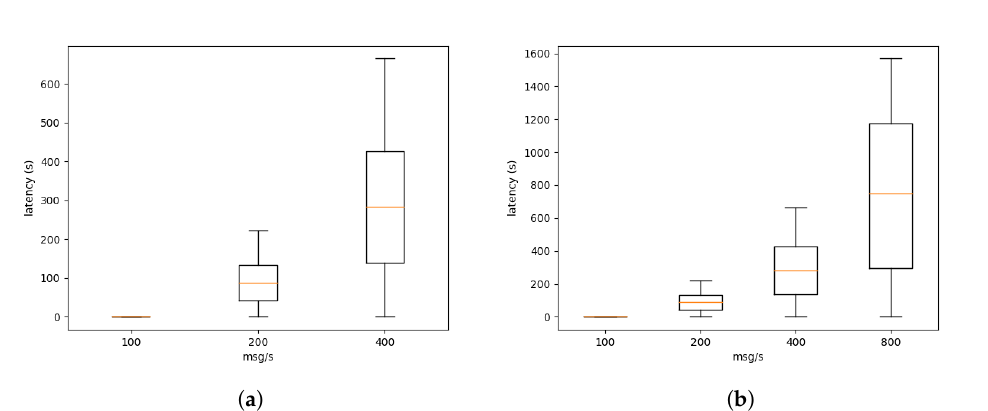
Figure 5. Latency at the ditto level. Due to the scaling issues ( a ) only shows from 100 to 400 msg/s while ( b ) shows from 100 to 800